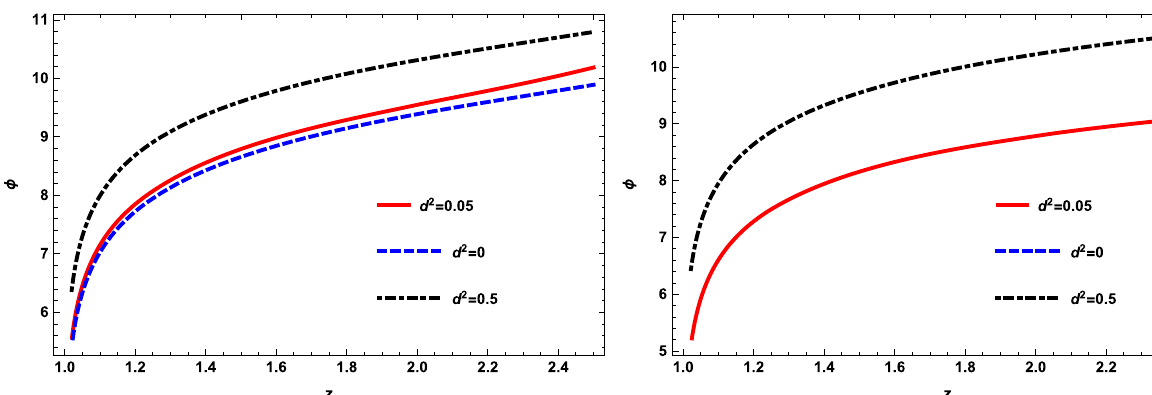
Fig. 34 Plot of φ verses z for u = 1 and u = 2 . 002 for quintessence scalar field model